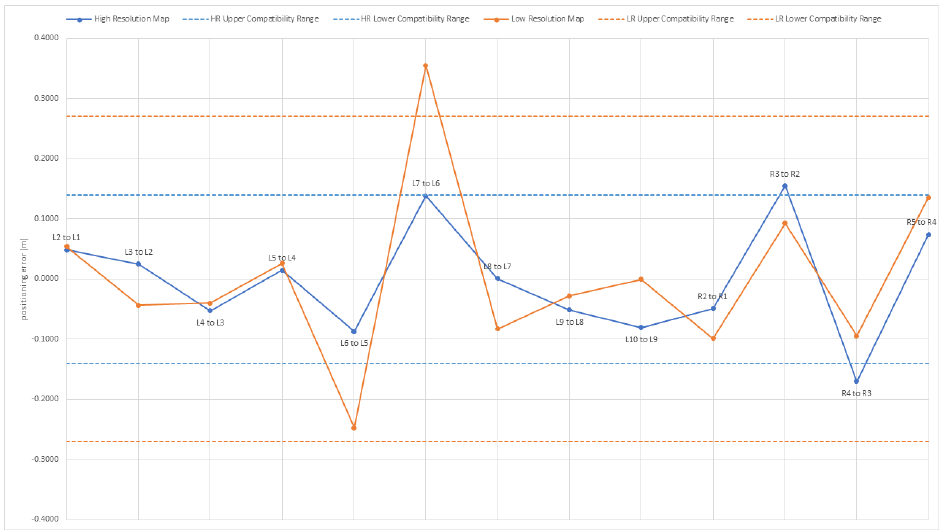
Figure 11. Distance errors relative to the temperature distribution maps produced in the indoor test environment. Dashed lines delimit the compatibility range in the two cases, which is equal to plus or minus the size of one voxel. The error standard deviation has been computed for both the low resolution map and the high resolution